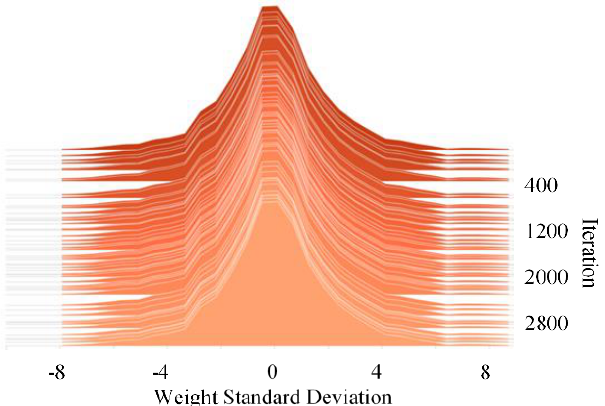
Figure 9. Histogram of standard deviation neural network weights over the number steps. Figure 10. Histogram of standard deviation neural network weights over the number steps.